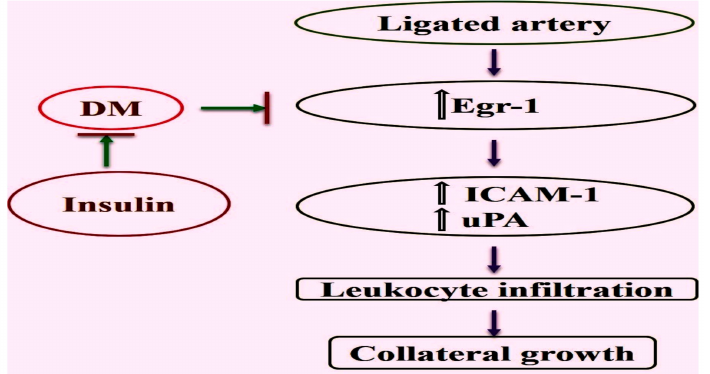
Figure 5. Graphical representation showing the mechanisms by which Egr-1 controls leukocyte recruitment, and hence, the process of collateral artery growth. While this process is impaired in DM due to the reduced Egr-1 expression, it can be rescued by insulin